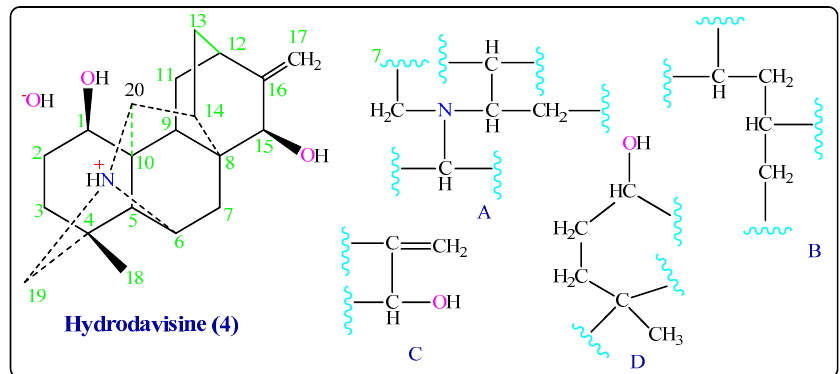
Figure 4. Partial structures of Hydrodavisine ( 4 ).